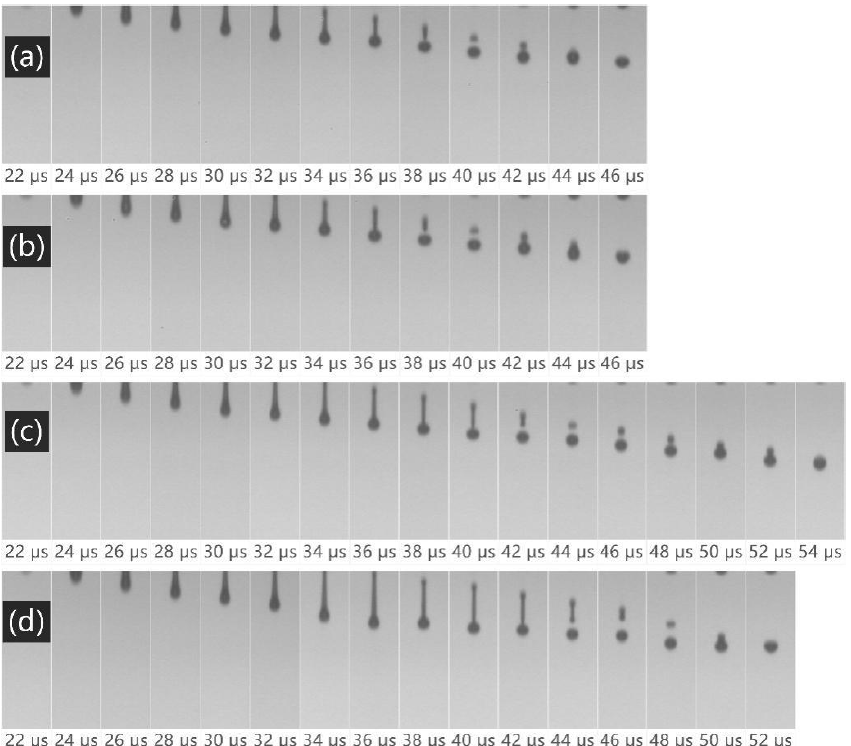
Figure 5. Ejection properties of disperse dye ink: ( a ) PVP ink, ( b ) PVA ink, ( c ) PEG in, ( d ) control sample.